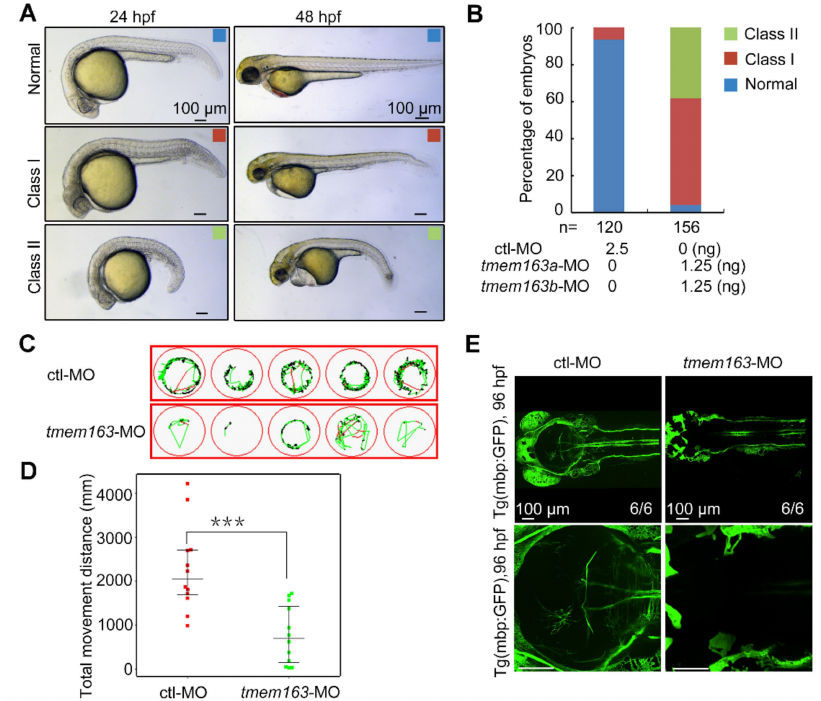
Figure 3. Impact of tmem163 knockdown on morphology, locomotor ability and myelination in zebrafish larvae: ( A ) Representative images of the normal (blue), mild (red), and severe (green) phenotypes observed in the control and tmem163 -MO injected groups at 24 hpf and 48 hpf. Scale bar: 100 µ m. ( B ) Quantification of the percentage of normal, class I, and class II in two groups obtained. The percentages of embryos with each phenotype are shown in the bar graphs, and the number of embryos examined is listed under each bar. ( C ) Examples of swimming tracks of five single larvae of each condition shown in green at 120 hpf. ( D ) Scatter plot displaying the total movement distance by different larvae: MO-control ( n = 12): 2689 ± 477 mm; tmem163-MO ( n = 12): 748 ± 200 mm. *** p < 0.01 (Student’s t -test). ( E ) Representative pictures of the Tg(mbp:GFP) larvae injected with control and tmem163 -MO at 96 hpf (dorsal views with anterior to the left). Scale bar: 100 µ